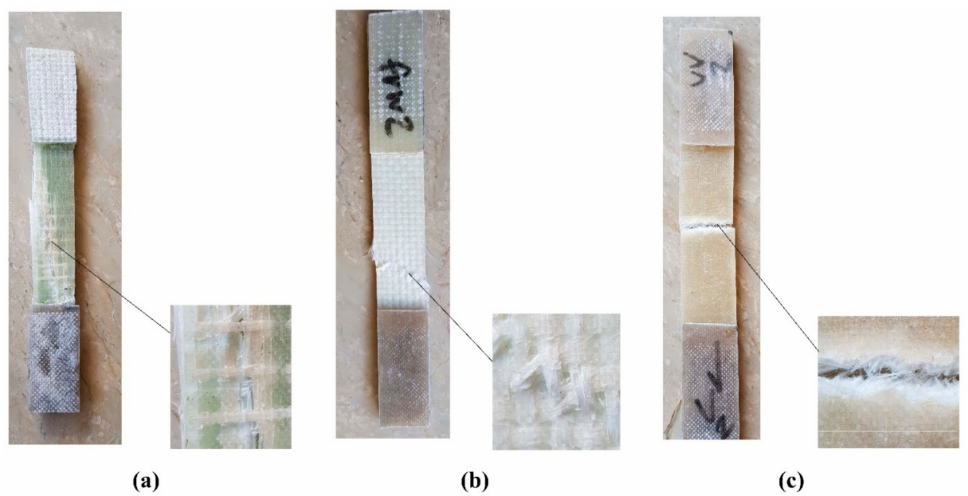
Figure 8. Typical failure modes of GFRP laminates: ( a ) Unidirectional laminate, ( b ) woven laminate and ( c ) chopped strand